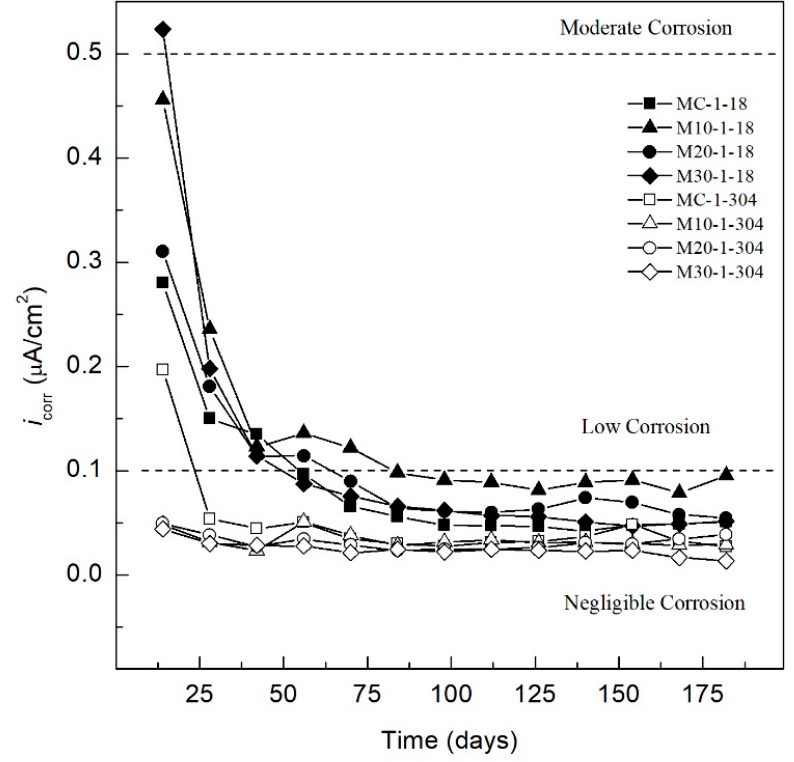
Figure 4. i corr specimens exposed to control medium (DI-water).